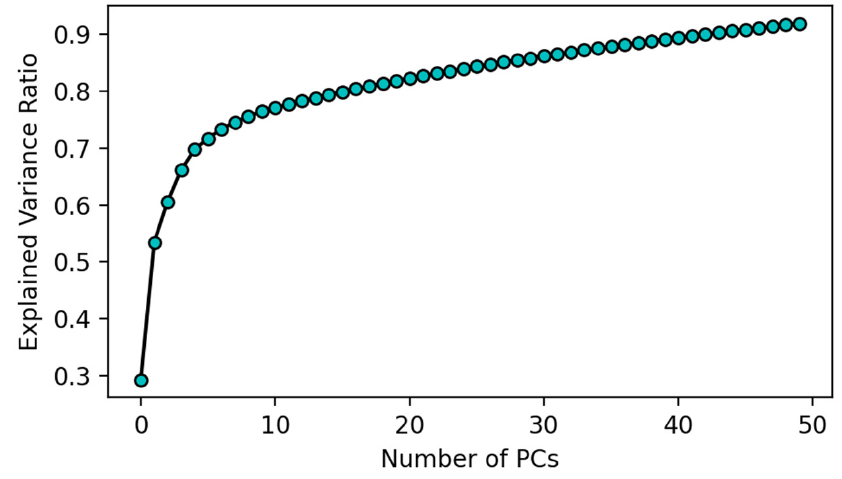
Figure 2. Explained Variance Ratio Plot for PCA.